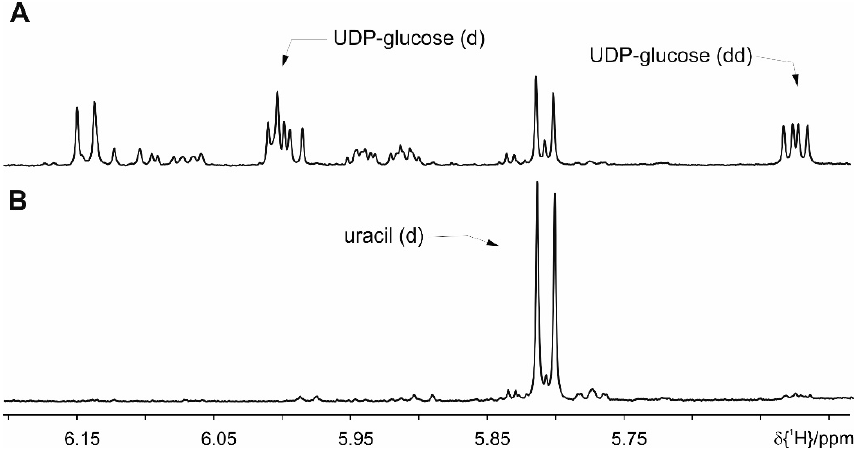
Figure 3. Comparison of the proton spectra taken within 24 h interval at room temperature: ( A ) fresh sample, ( B ) after 24 h.